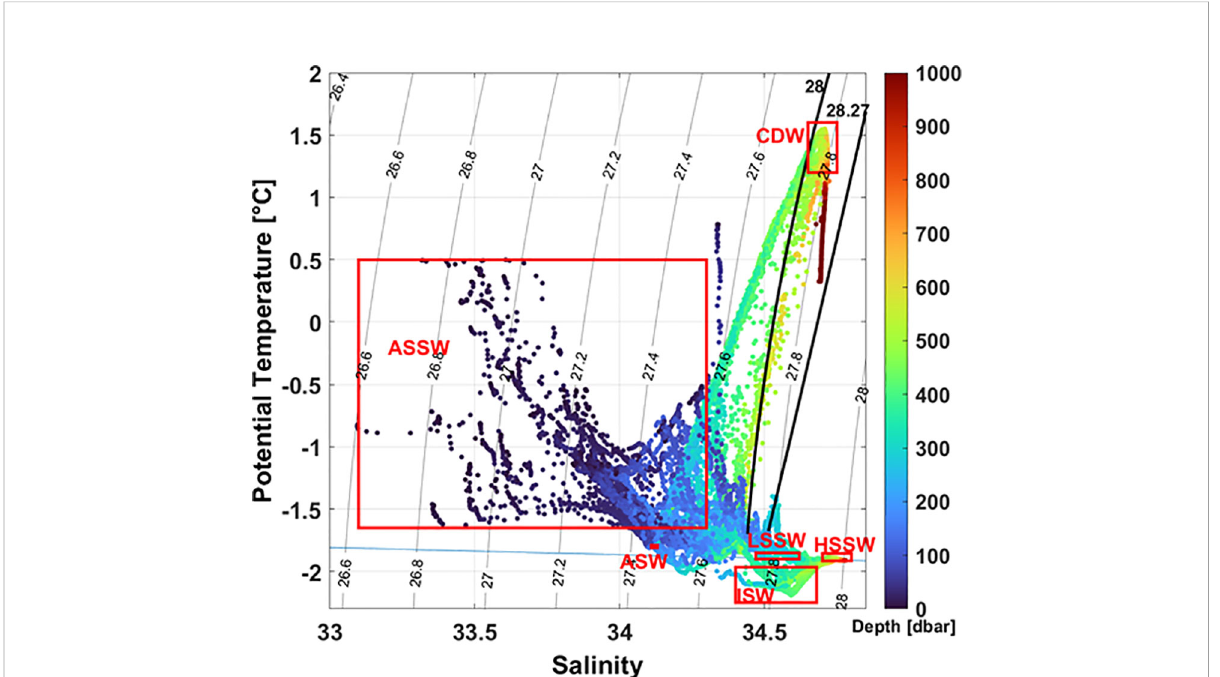
FIGURE 2 Potential temperature salinity ( q /S) plot. Solid lines show the 28.00 and 28.27 kg m -3 neutral density g n surfaces. The blue horizontal line shows the surface freezing point of seawater. Major water masses are labeled: Antarctic Surface Water (AASW), Circumpolar Deep Water (CDW), High Salinity Shelf Water (HSSW), Low Salinity Shelf Water (LSSW), Ice Shelf Water (ISW), and Amundsen Sea Water